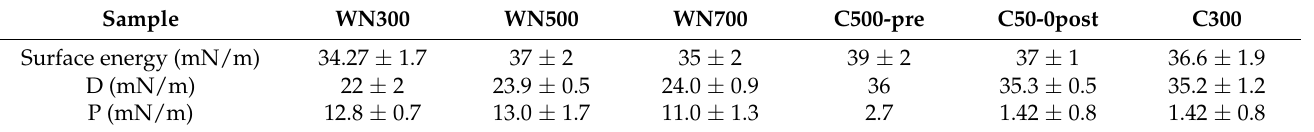
(WCA°) of the three annealed WN x samples are reported.